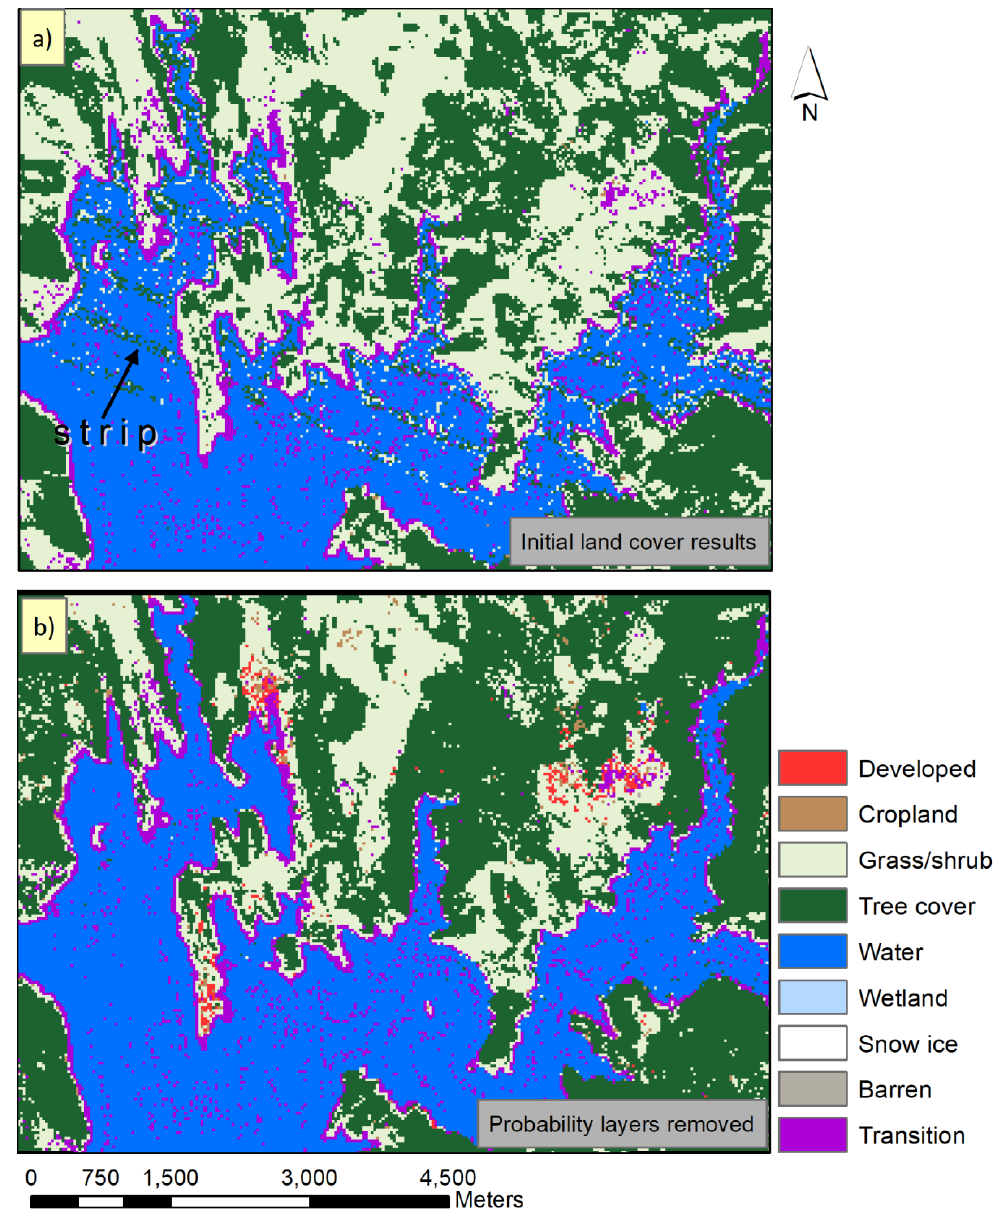
Figure 2. Example of the classification problem in 1995 at New Melones Lake, California (38 ◦ 0 ’ 21.26” N , 120 ◦ 33 ’ 19.20” W ). Panel ( a ) shows the Landsat 7 ETM+ Scan Line Corrector (SLC)